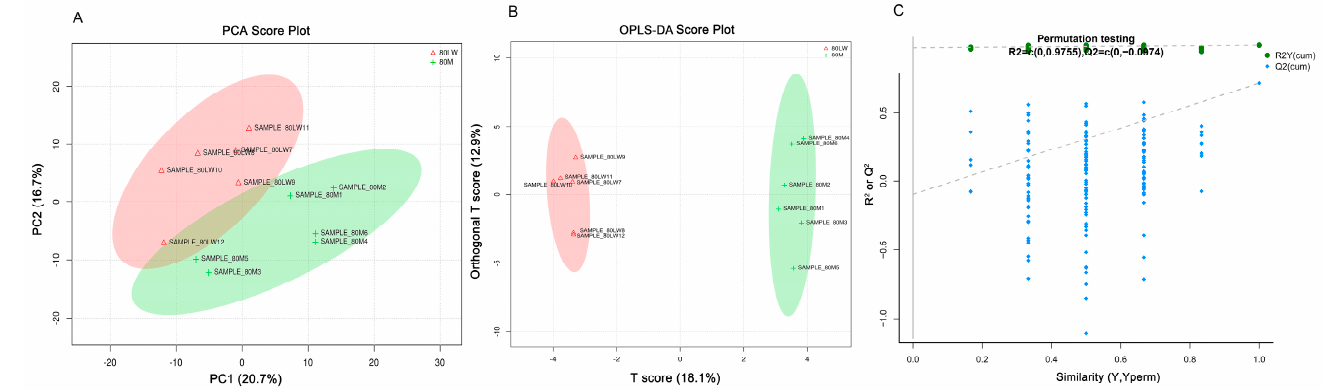
Figure 1. Principal component analysis (PCA). ( A ) PCA score plot of the serum of Large White (LW) and Min (M) pig metabolites; ( B ) Orthogonal partial least squares discrimination analysis (OPLS-DA) score plot; ( C ) The 200-response sorting permutation test plot in the OPLS-DA mode.